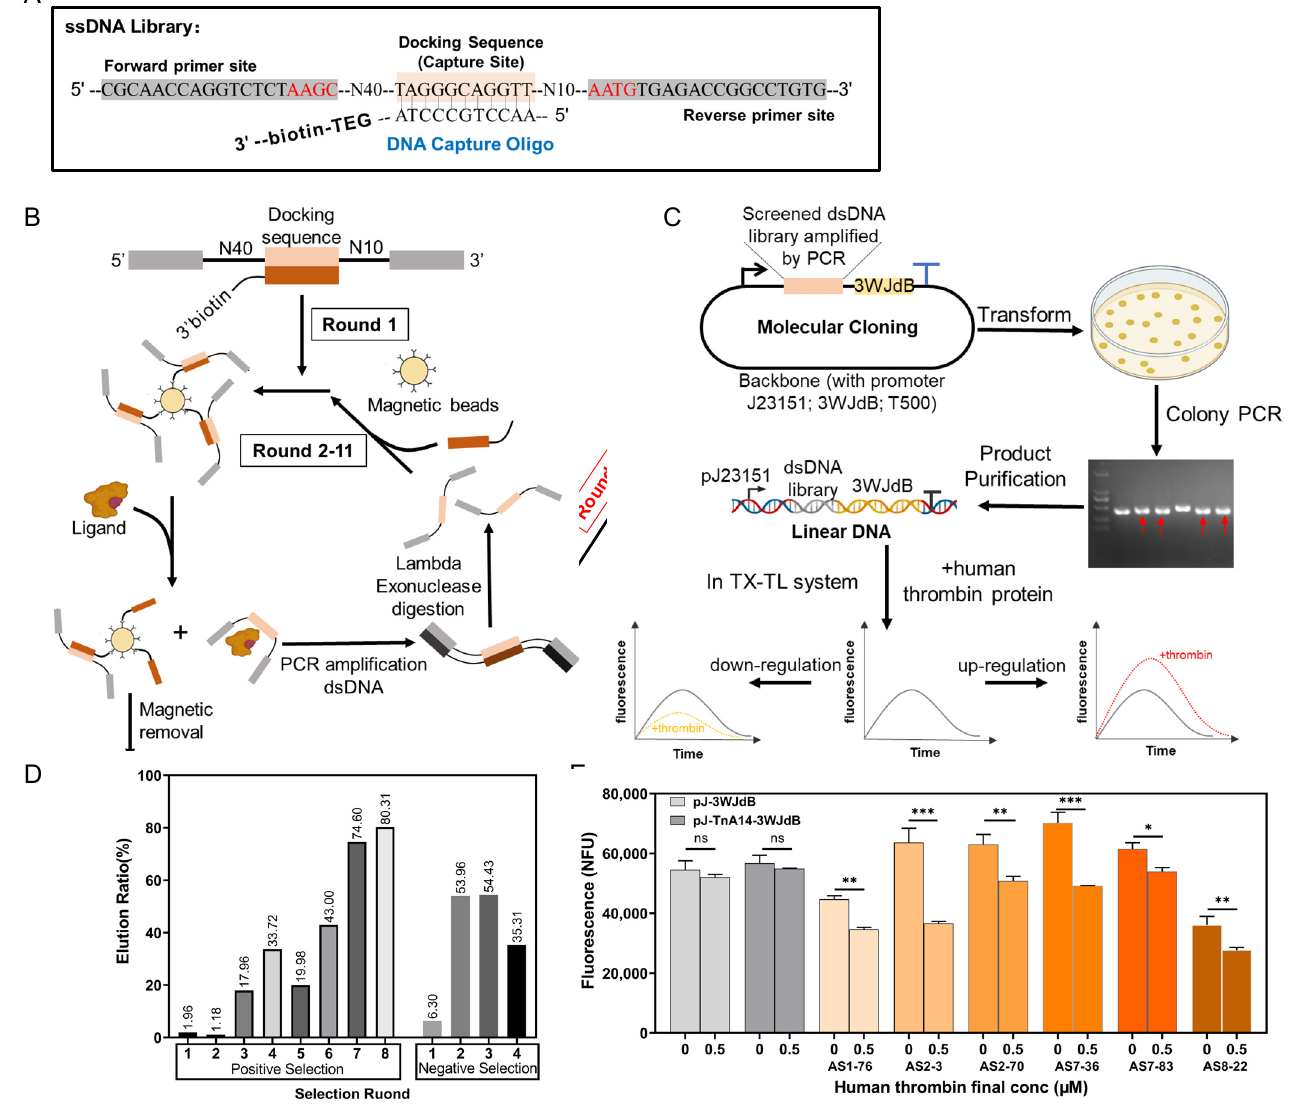
Figure 1. CIVT-SELEX is used to select human thrombin aptamers that can regulate transcription. ( A ) Design of the DNA library used in Capture-SELEX. ( B , C ) Schematic representation of CIVT- SELEX. ( D ) Elution ratios of 8 rounds Capture-SELEX positive selection and 4 rounds of negative selection. ( E ) Endpoint measurements of the experimental groups (linear DNAs with a final concen- tration of 50 nM) with and without 0.5 μ M human thrombin protein in the cell-free system. The data also include the results of the positive control pJ23151-3WJdB-T500 (pJ-3WJdB) and the negative